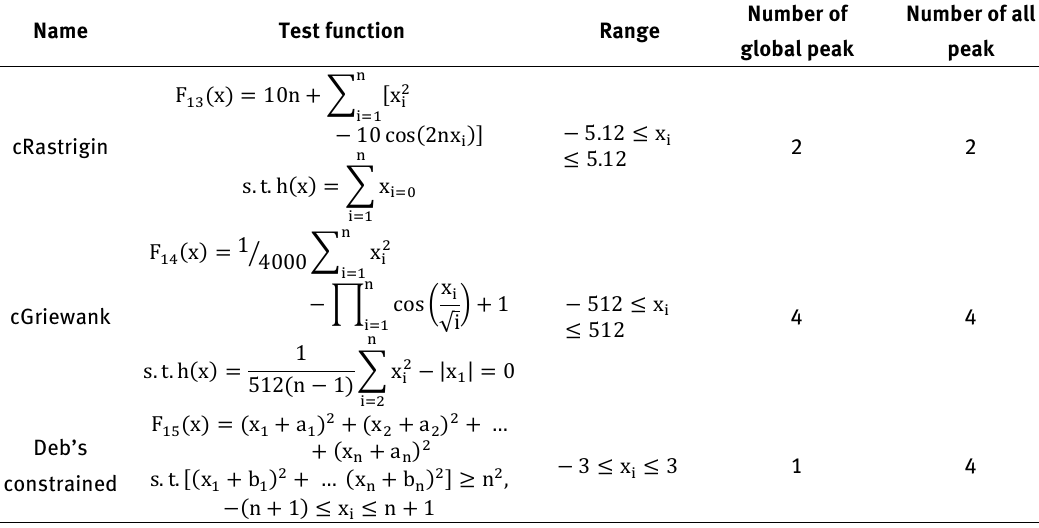
Table 2A: Constrained test functions in the experiments (see [15])